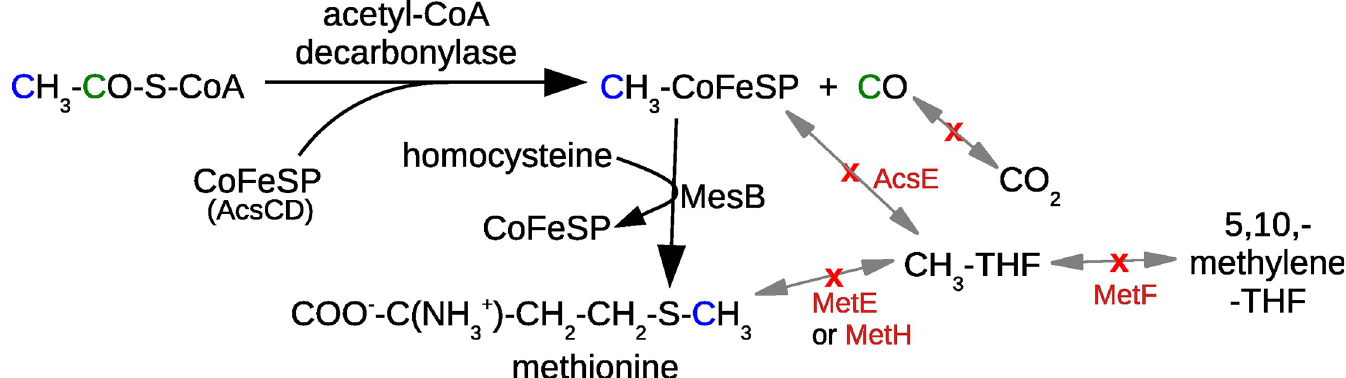
Fig 2. The proposed pathway for methionine synthesis in Dehalococcoides mccartyi . Steps that are absent from D . mccartyi are shown with a red x.